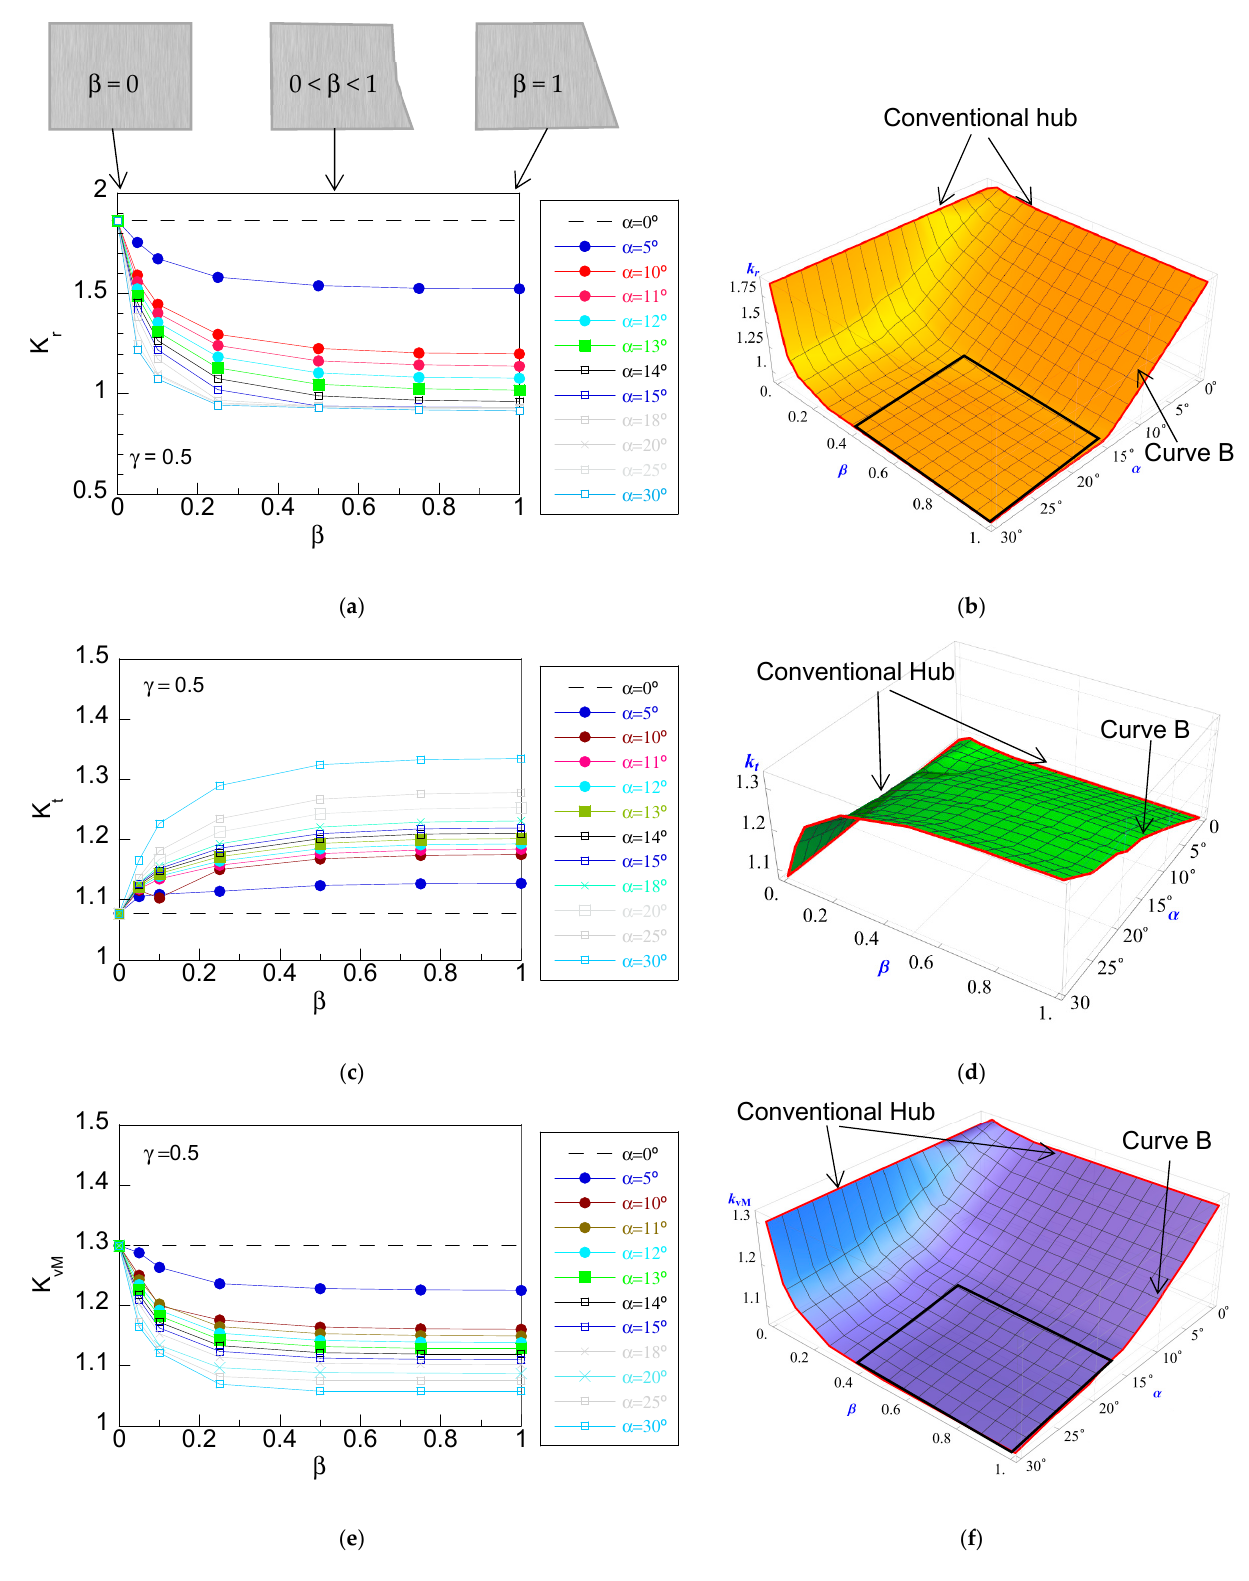
Figure 12. Stress concentration factors as a function of chamfer height β for diverse values of chamfer angle α in partial–chamfer hubs with a hub thickness of γ = 0.5. ( a ) radial stress, ( b ) 3D view, ( c ) tangential stress, ( d ) 3D view, ( e ) von Mises stress, ( f ) 3D view. The line in the plane β = 0 and the line in the plane α = 0° represent the conventional hub; hence, no variation appeared with the other variables. The curve shown in the plane